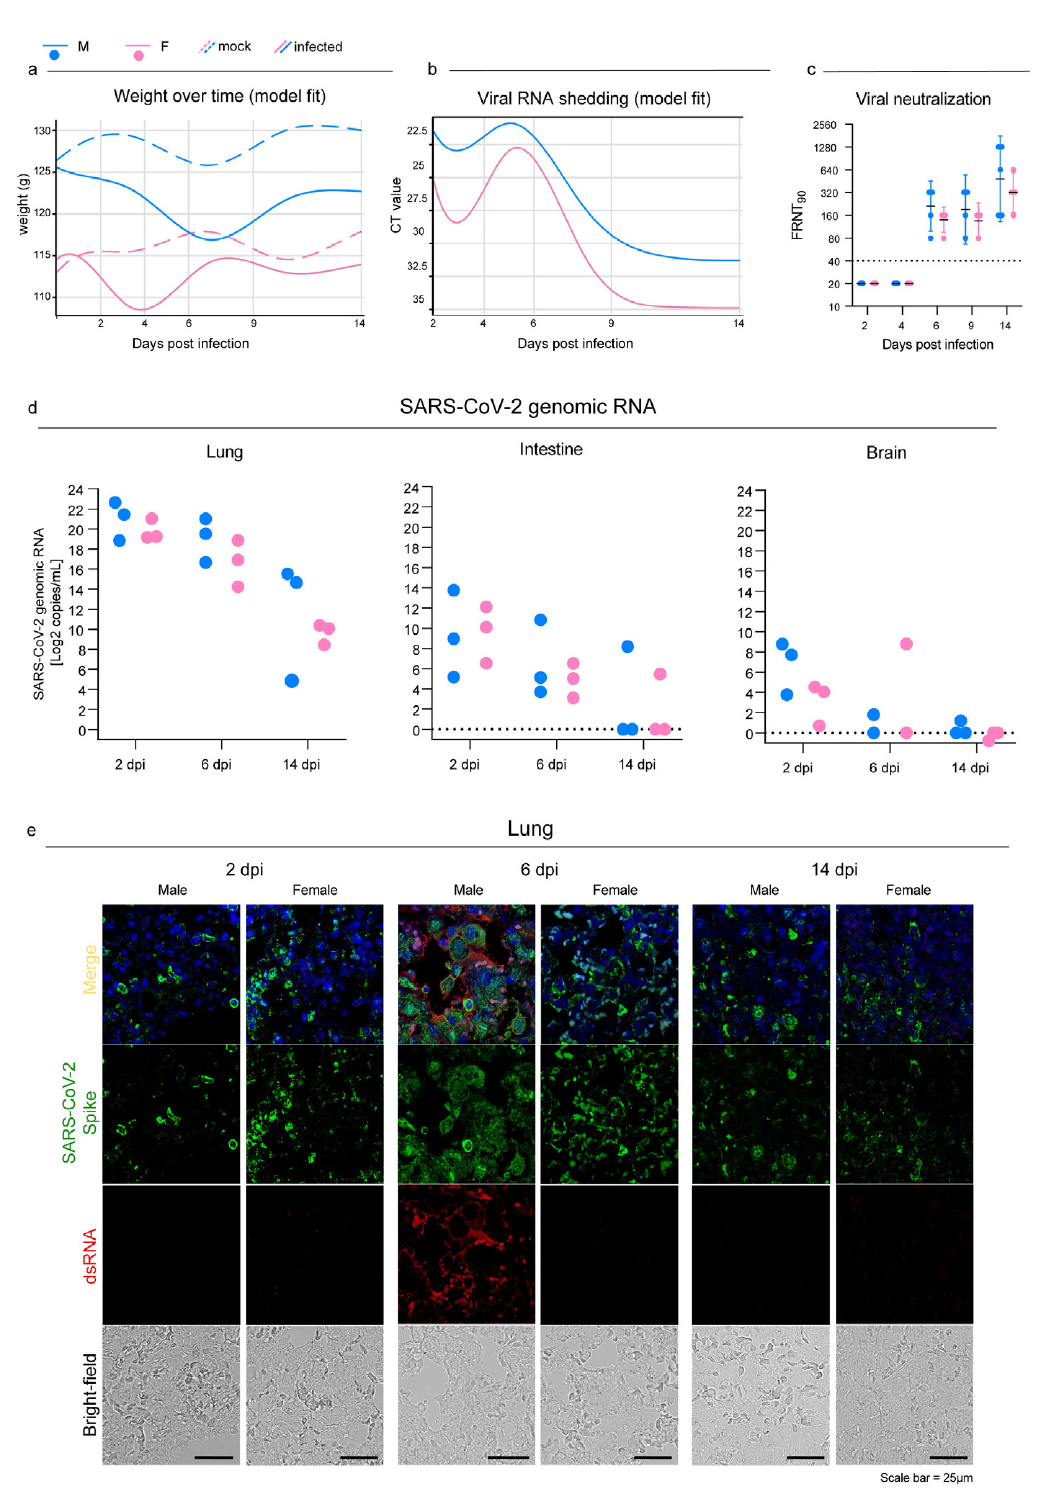
Figure 1. SARS-CoV-2 infection in oropharyngeal swabs, lungs, and distal organs. ( a ) Statistical model describing body weight over time in mock and infected male (Mock M, M) and female (Mock F, F) Syrian hamsters. ( b ) Statistical model describing rRT-PCR results trend of RNA extracted